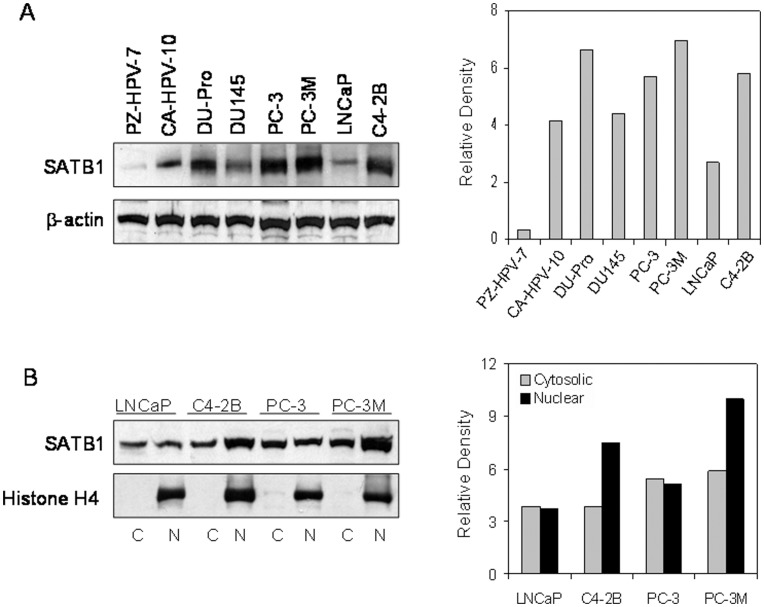
SATB1 protein expressions in virally transformed prostate epithelial cells, and various prostate cancer cells.(A) Western blotting for SATB1 protein expression in various prostate cancer cells; CA-HPV-10, DUPro, DU145, PC-3, PC-3M, LNCaP and C4-2B including transformed epithelial (PZ-HPV-7), cells. (B) Cytoplasmic and nuclear SATB1 protein expression was analyzed in prostate cancer parental cell lineage and their aggressive subclones LNCaP and C4-2B; PC-3 and PC-3M which represented higher nuclear presence of SATB1 in aggressive subclones. Histone H4 served as loading control. Densitometric analysis for each blot is shown in the right panel. Details are described in ‘materials and methods’ section.